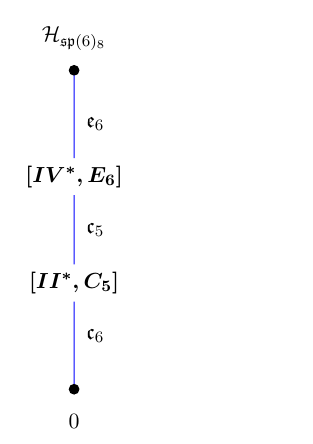
Figure 16. The Hasse diagram for the Higgs branch of the sp (7) 9 theory.